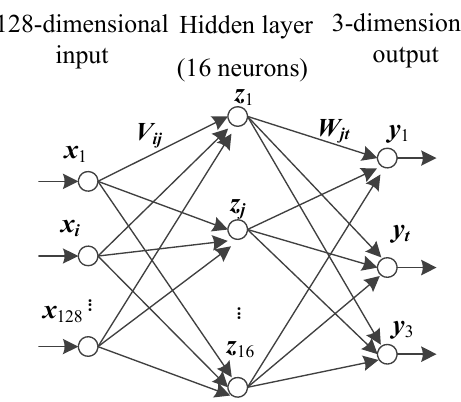
Fig. 3 BP neural network structure.